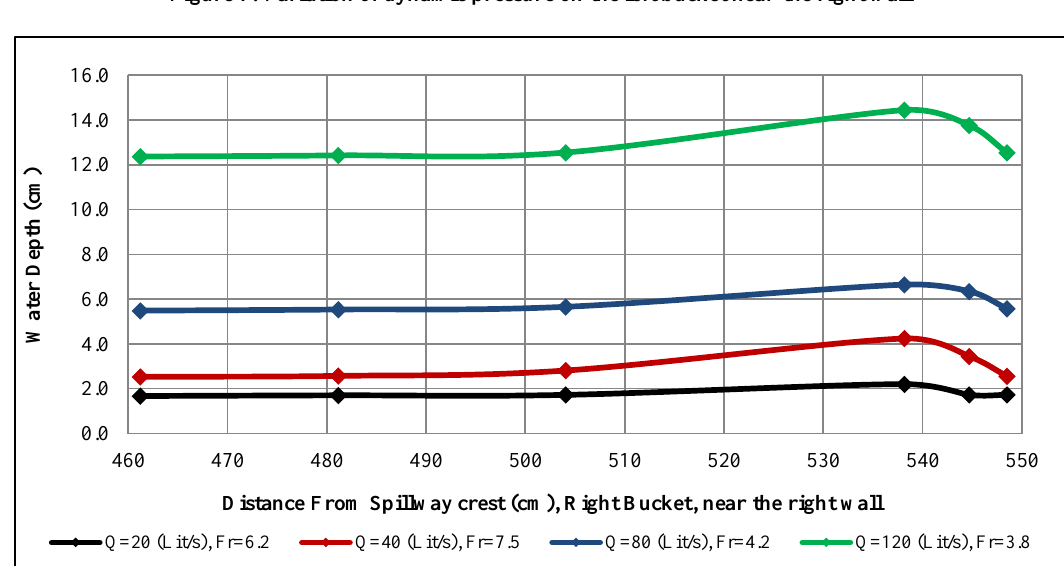
Figure 7. Variation of dynamic pressure on the left bucket near the right wall